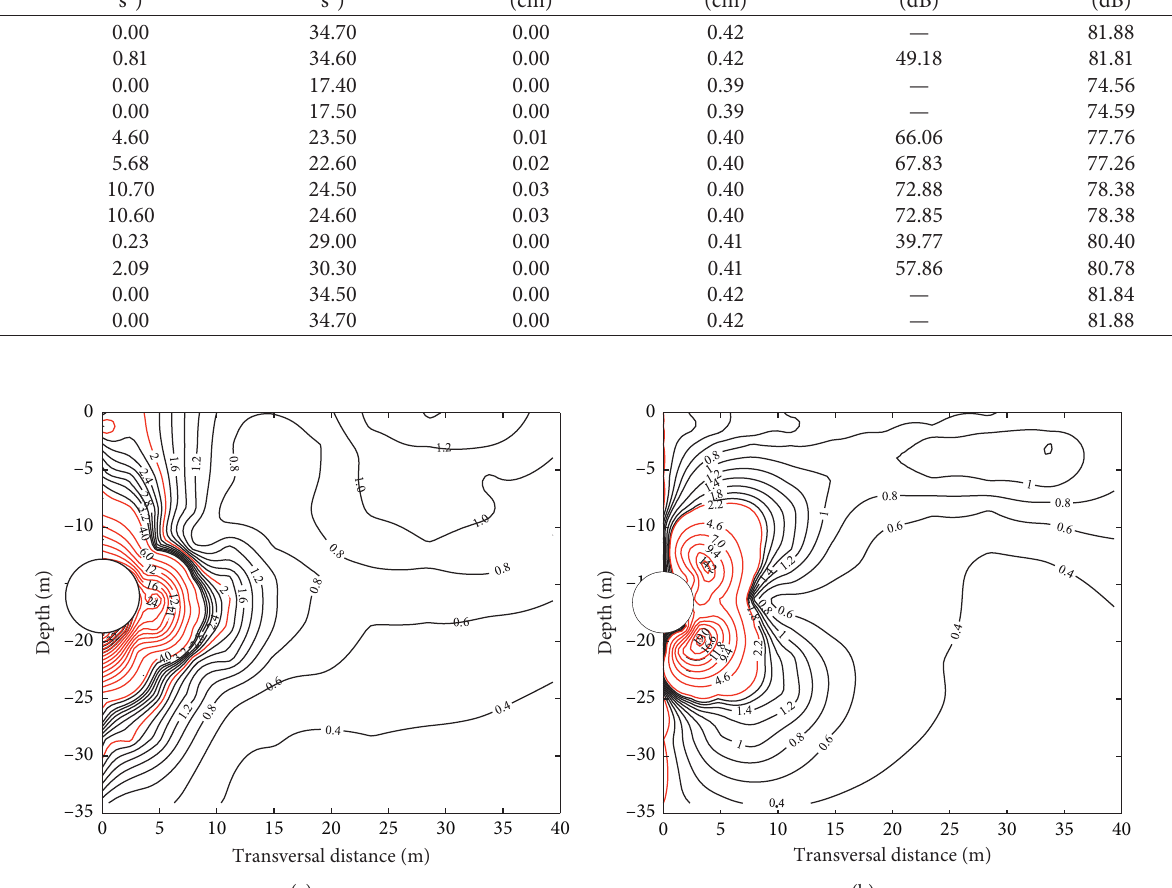
Figure 25: Acceleration contour of the soft ground: (a) vertical direction; (b) transversal direction (unit: cm/s 2